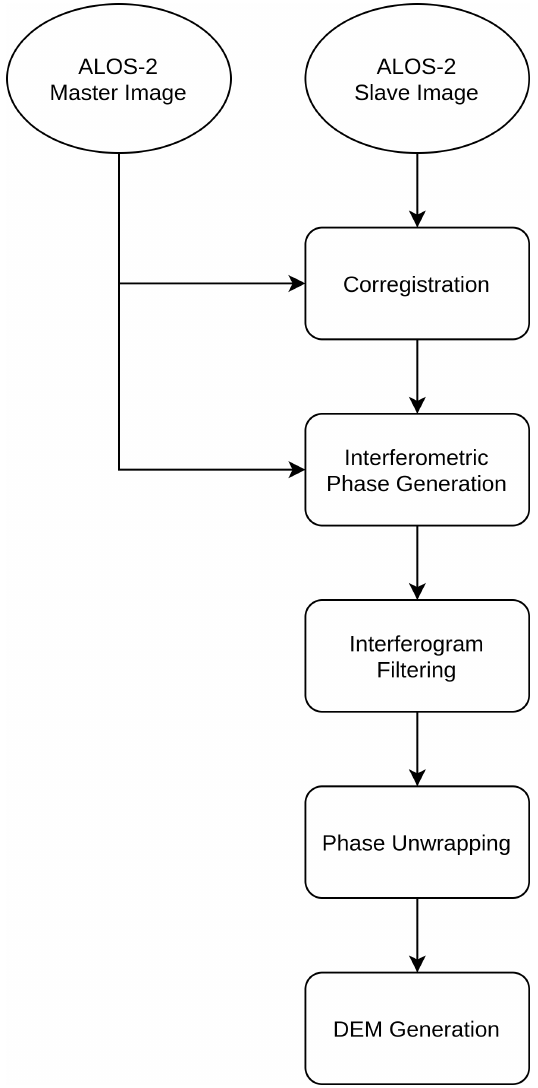
Figure 2. Flowchart of SAR Interferometric Processing